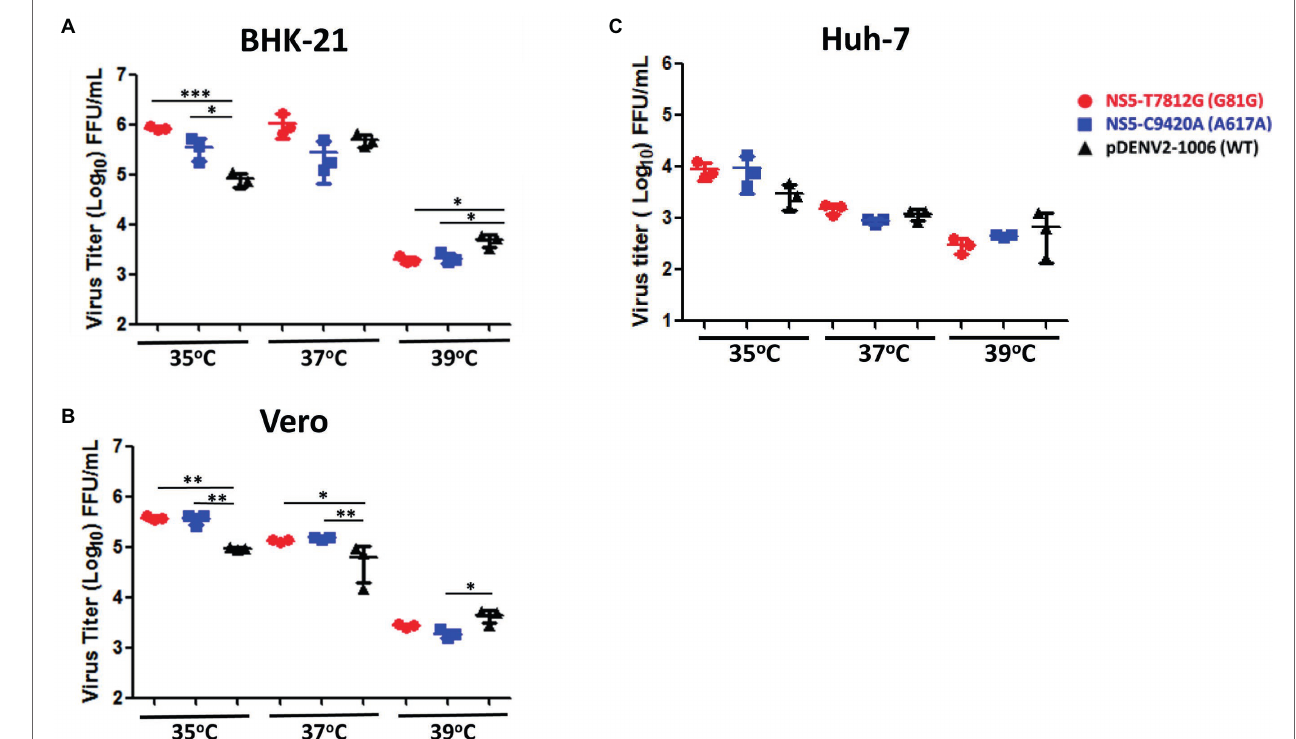
FIGURE 5 | Thermal sensitivity of virus variants and WT virus. BHK-21 (A) , Vero (B) , and Huh-7 (C) cells were infected with virus variants and WT virus at a MOI of 0.01. Infected cells were incubated at three different temperatures (35 ° C, 37 ° C, 39 ° C) for 4 days. Virus titers were quantified via flow cytometry and ELISpot. Titers were calculated for FFU/mL. The circle, square and triangle symbols represent NS5-T7812G (G81G), NS5-C9420A (A617A), and pDENV2-1,006 (WT- NS5- 7812 T/9420C) viruses, respectively. Asterisks (*) indicate a significant difference with WT. Statistical difference comparing virus variants with wildtype was calculated using two-way ANOVA. * p < 0.05, ** p < 0.01, and *** p <